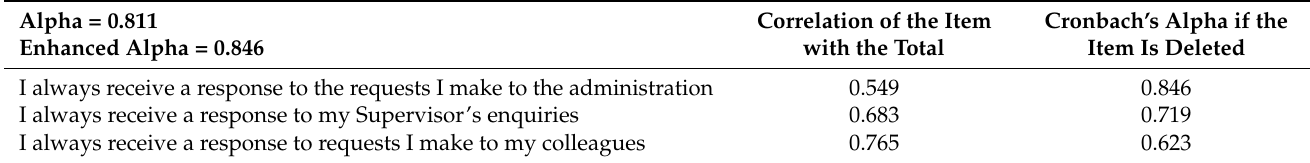
Table 8. Reliability of the dimension “Response to